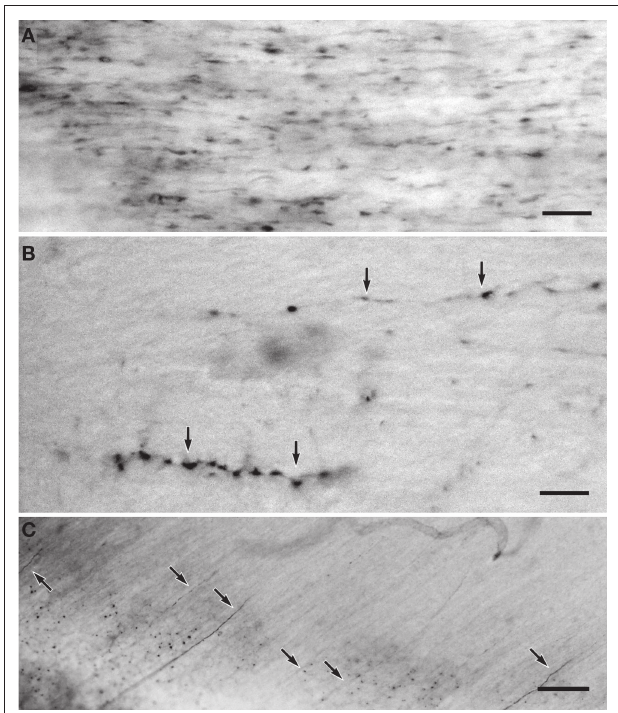
FIGURE 2 | (A) GFP-positive axon fi bers in the fi mbria of the GAD67-Cre/GFP Cre-reporter mouse brain. (B) GFP-positive axon fi bers in the anterior commissure. (C) NADPH-d positive axon fi ber fragments in the mouse fi mbria. Calibration bar in (A,B) are 10 µm; calibration bar in (C) is 30